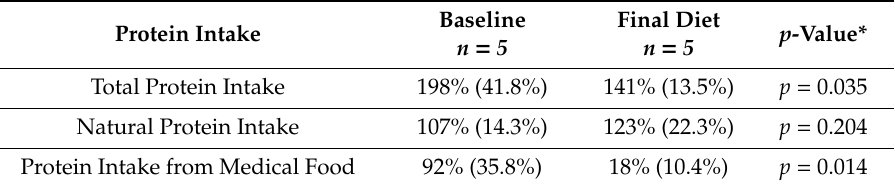
Table 1. Paired sample t-test results of dietary composition reflected as percentage of the Recommended Dietary Allowance (RDA). Protein Intake